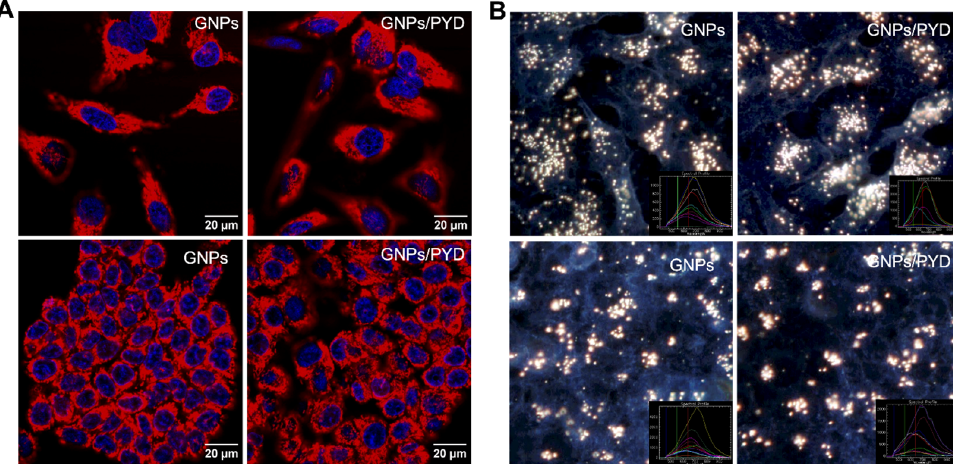
Figure 5. Qualitative analysis of GNP uptake in the absence and presence of PYD in HeLa (top) and HCT-116 (bottom) cells. ( A ) Live cell confocal images of intracellular distribution of GNPs in HeLa and HCT-116. The left and right columns show the distribution of GNPs in the absence and presence of PYD, respectively. Red and blue colors represent GNPs and nuclei stain, respectively. ( B ) Hyper- spectral images of intracellular distribution of GNPs in HeLa and HCT-116. The left and right col- umns show the distribution of GNPs in the absence and presence of PYD, respectively. The inset figure in each image shows the spectra collected from GNP clusters. Cells were dosed with GNPs and PYD at a concentration of 7.5 µg/mL and 500 nM, respectively.